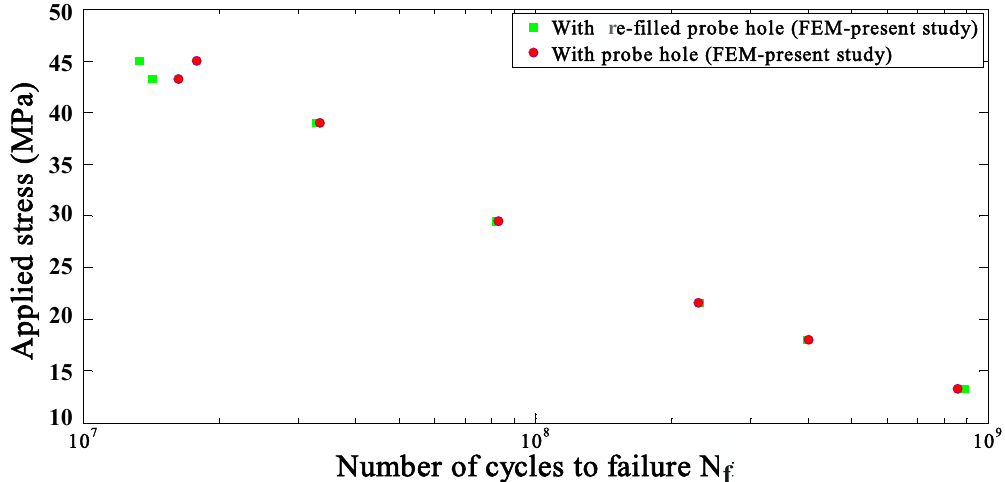
Figure 8. The fatigue life for different maximum stress applied to structures far away from the welding area for R = 0.1.